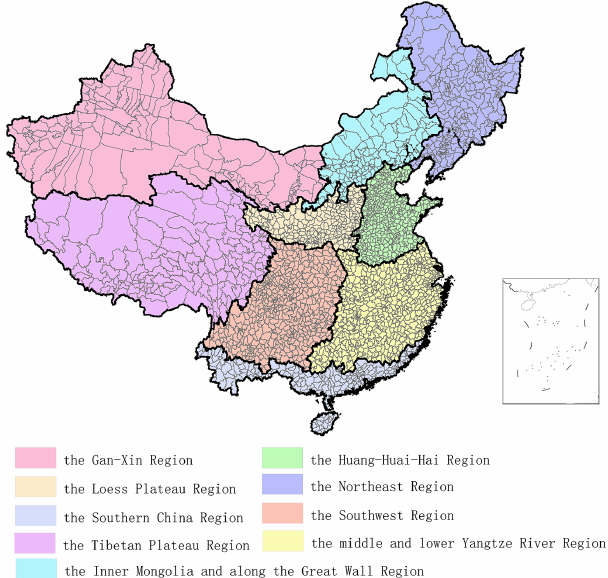
Figure 3. The nine agriculture regions in China. The thin black line represents the county boundary and the small insert represents the South China Sea and its